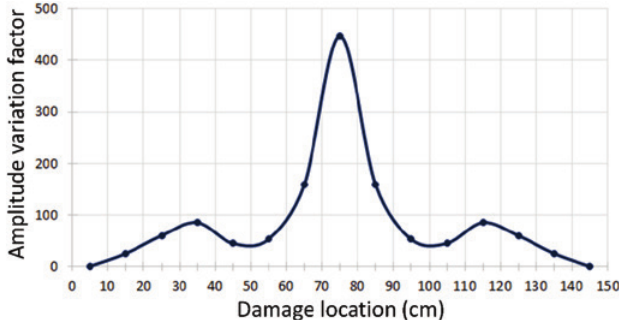
Figure 10 Amplitude variation factor of ASD method versus the position of the damage in the model with only one are clear and the location is correct. In contrast, in the ASD method, the amplitude of the damage located at 75 cm (middle